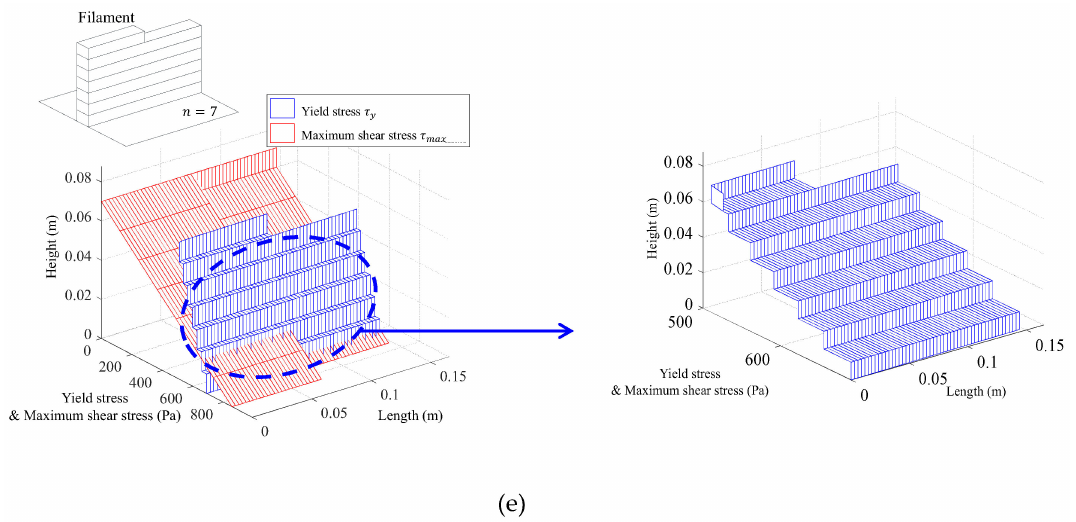
Figure 11. Comparison of yield stress and maximum shear stress. ( a ) Maximum shear stress & yield stress at n = 1; ( b ) Maximum shear stress & yield stress at n = 3; ( c ) Maximum shear stress & yield stress at n = 5; ( d ) Maximum shear stress & yield stress at n = 6; ( e ) Maximum shear stress & yield stress at n = 7.